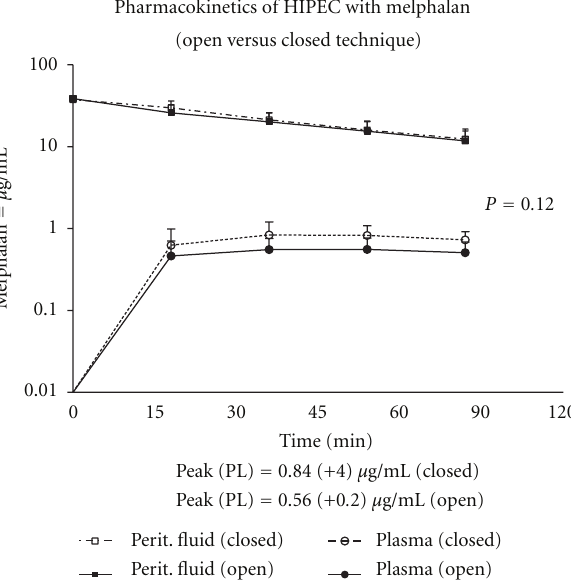
Perit. fluid (closed)